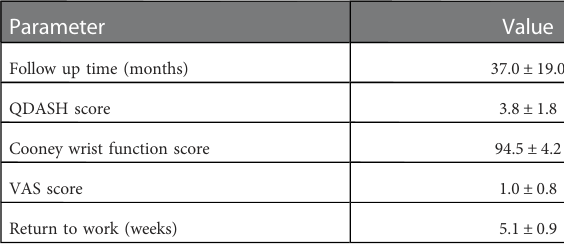
TABLE 3 Function outcome of patients ( n